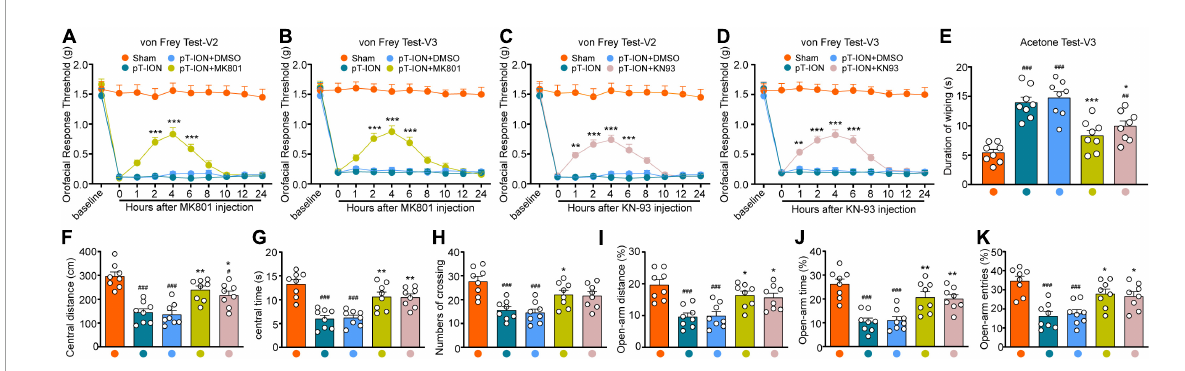
FIGURE4 The orofacial allodynia and anxiety-like behavior after MK801 and KN-93 administration. The mechanical hypersensitivity in both V2 and V3 areas were attenuated by LHb administration of the NMDA receptor antagonist MK801 (from 2 to 6 h after injection; A,B ) and CaMKII inhibitor KN-93 (from 1 to 6 h after injection; C,D ) at day 21 after pT-ION. In acetone test, The increased duration of wiping induced by pT-ION was decreased by MK801 and KN-93 at 4 h after injection (E) . The reduced central distance (F) , central time (G) , numbers of crossing (H) in the OFT and the reduced percentage of open-arm distance (I) , open-arm time (J) , and open-arm entries (K) in EPM test induced by pT-ION were significantly reversed at 4 h after LHb injection of MK801 and CaMKII. N = 8 mice per group, # p < 0.05, ## p < 0.01, ### p < 0.001 vs. the Sham group; * p < 0.05, ** p < 0.01, *** p < 0.001 vs. the pT-ION+DMSO group.